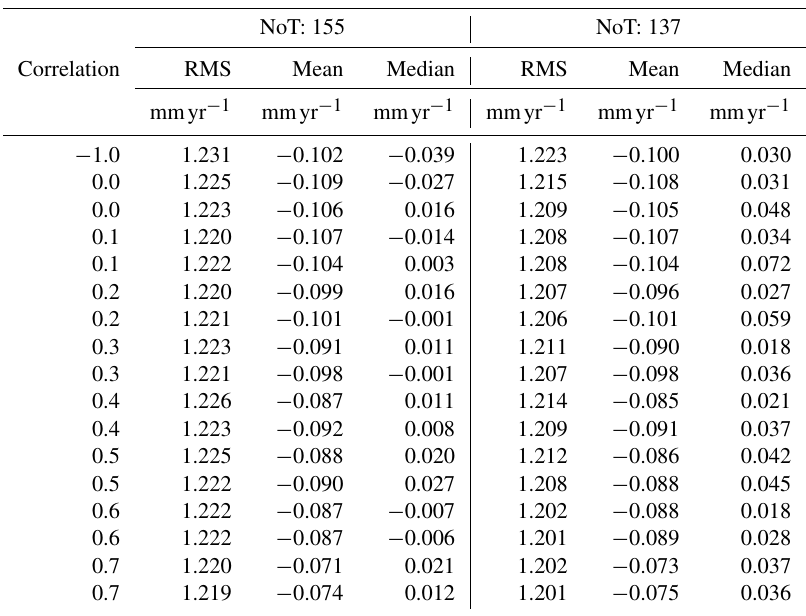
Table 5. Statistics of ALT–TG trend differences with the median GNSS approach for various correlation settings after applying a correction for nonlinear VLM. NoT: 155 NoT: 137 Correlation RMS Mean Median RMS